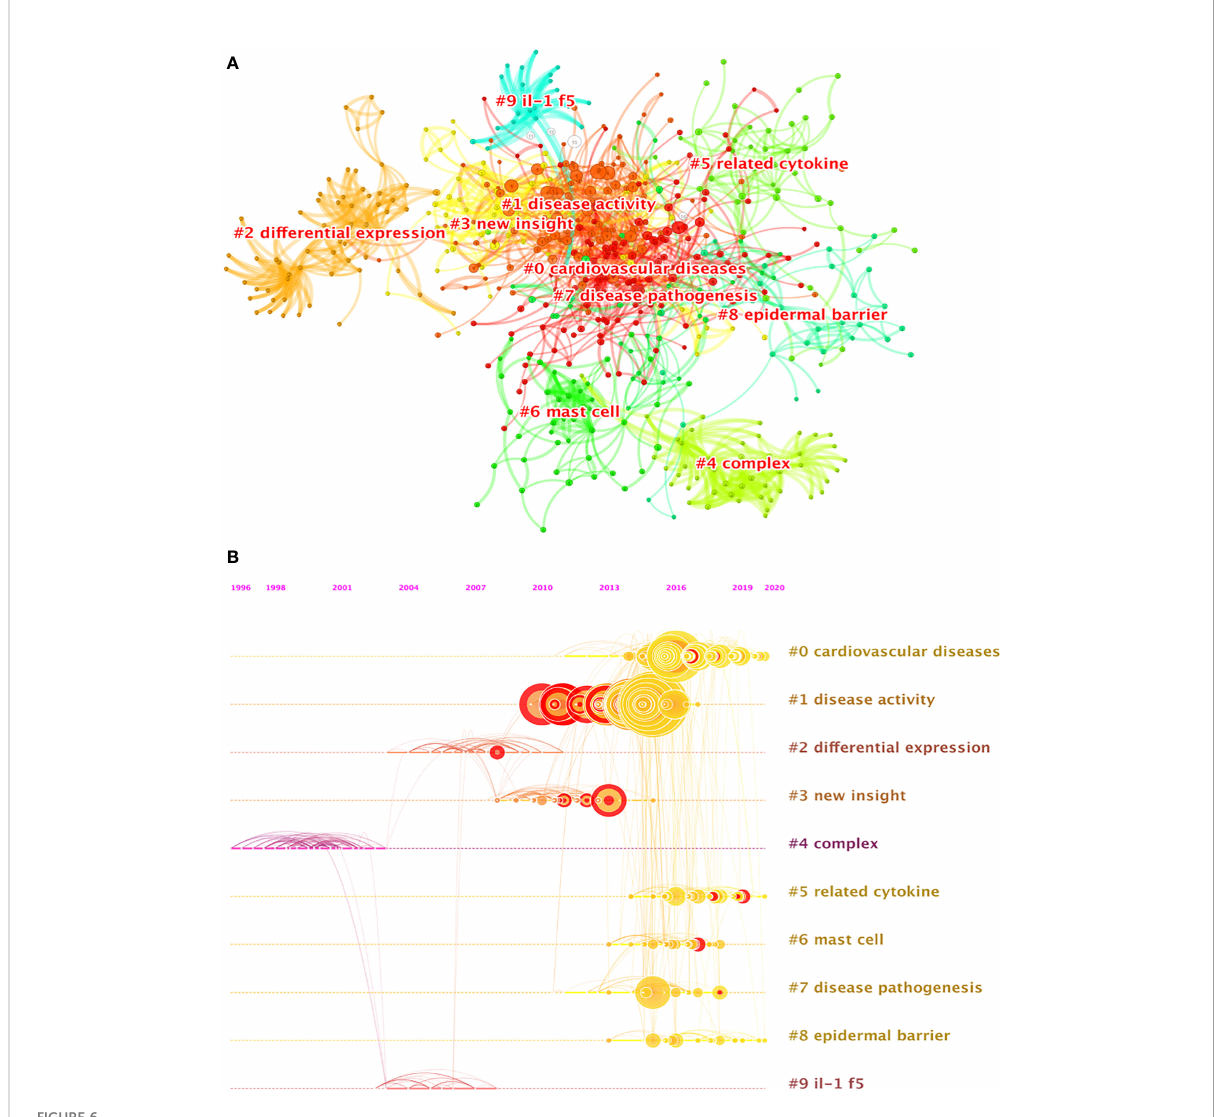
FIGURE 6 (A) The clustered network map of co-cited references on IL-37 research. (B) The timeline view of co-citation